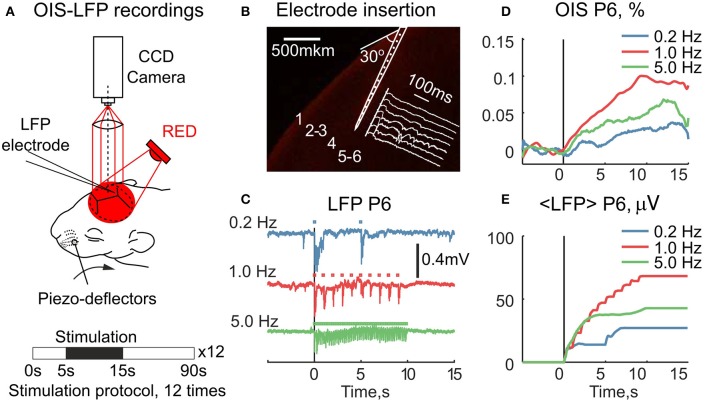
Simultaneous recordings of the RED OIS and electrical activity in the barrel cortex of neonatal rats. (A) Setup for simultaneous registration of OIS and LFP. (B) An example of a silicon probe inserted into the principal barrel of a P6 rat. The probe was stained with DiI (Sigma, 42364) before insertion. (C) LFP traces at different stimulation rates. Square markers indicate individual stimuli within the train. (D,E) The time course of the simultaneously recorded RED OIS and average LFP (< LFP >) in a P6 rat.